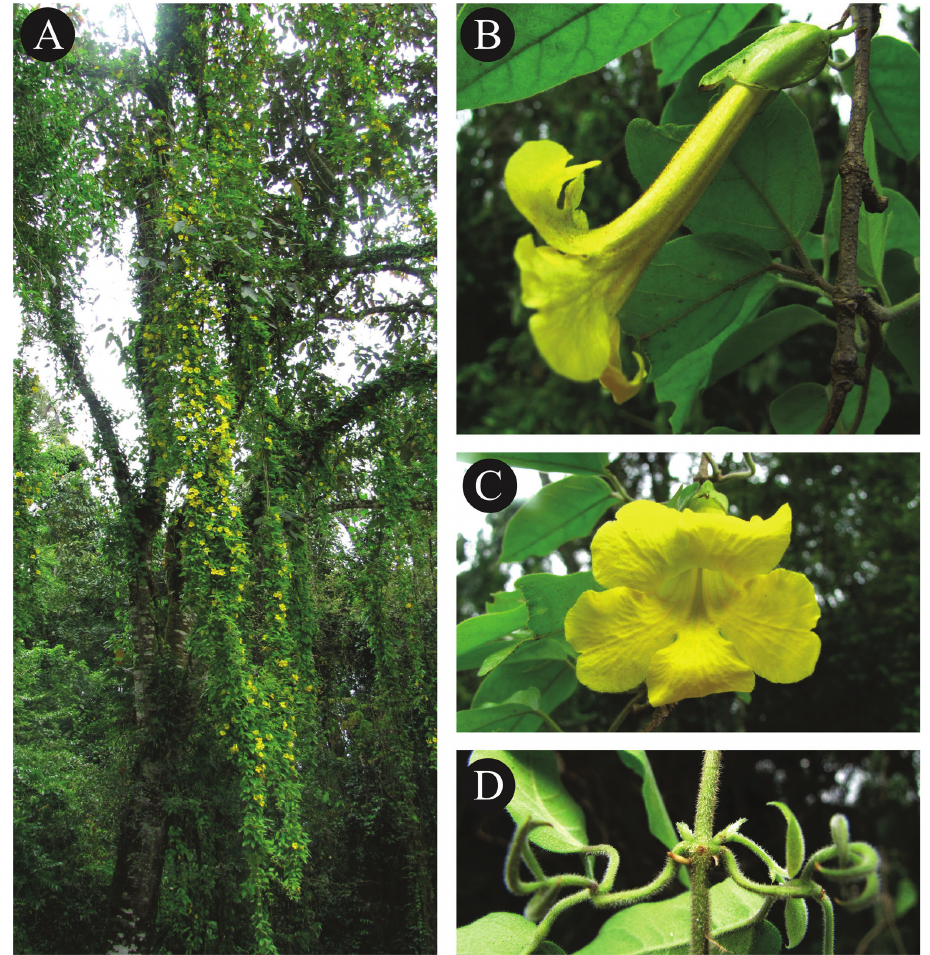
Figure 1. A Habit of Dolichandra hispida B Lateral view of flower C Flower frontal view showing the opening of the flower tube D Node branch showing the hispid indument (Photos L.H.M.